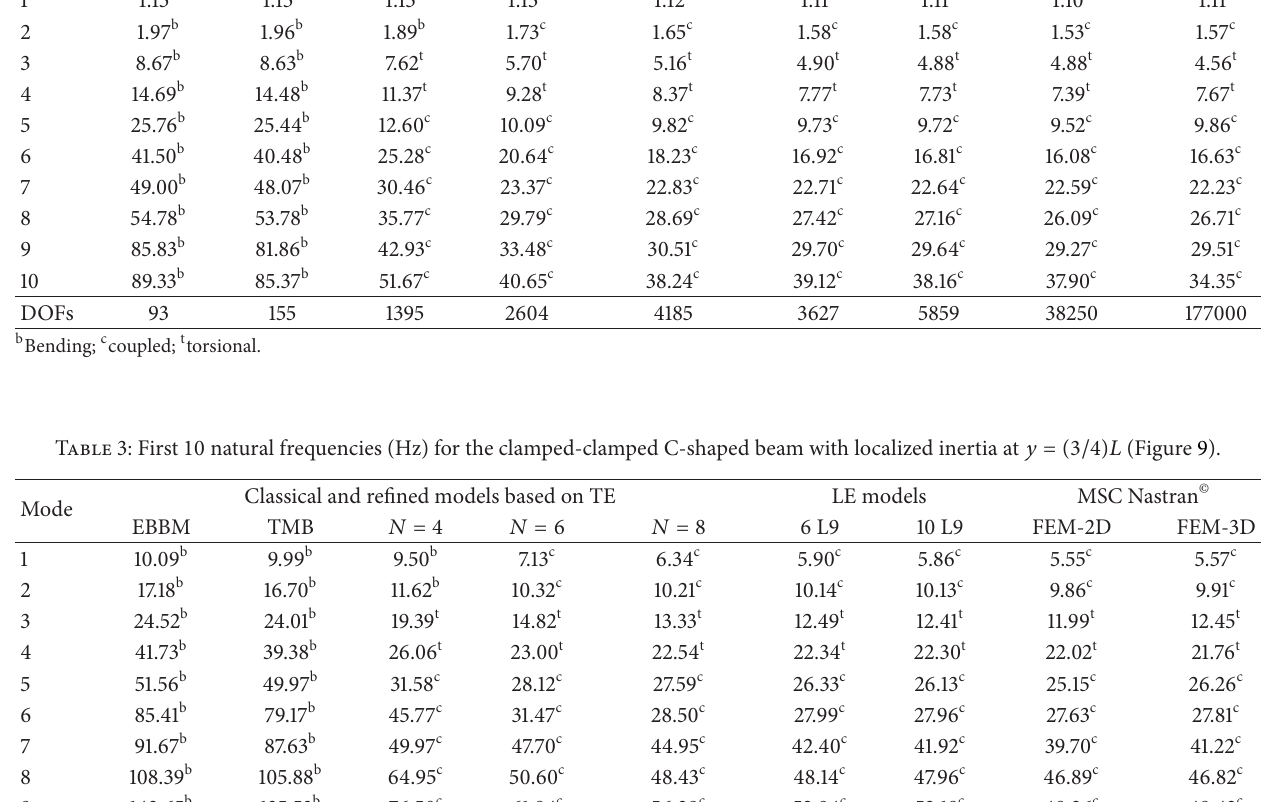
Table 2: First 10 natural frequencies (Hz) for the cantilever C-shaped beam with localized inertia at the tip cross-section (Figure 9). Mode